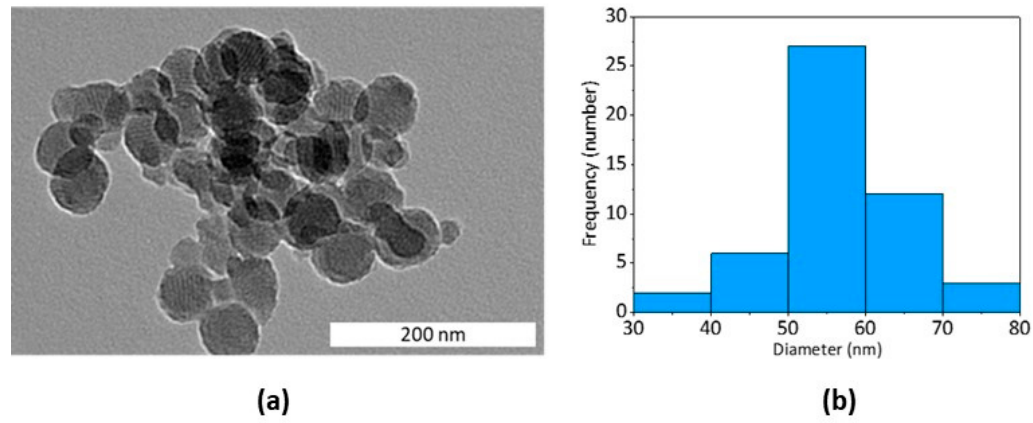
Figure 1. ( a ) TEM image of the MSNs, showing their ordered porous structure. ( b ) Particle diameter distribution obtained by the analysis of 50 particles in TEM images.